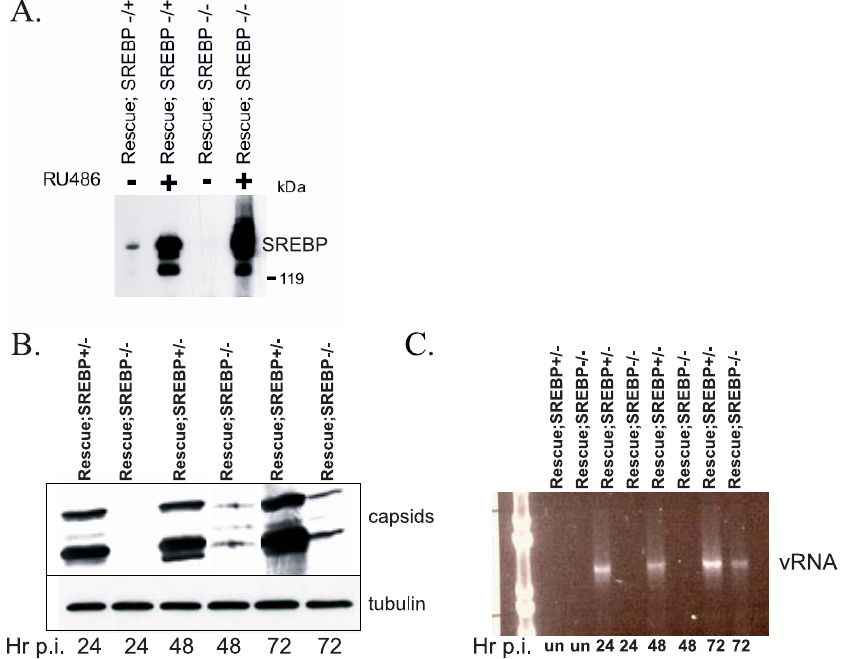
Figure 5. Attenuation of Fatty Acid Biosynthesis in Animals Is Protective (A) SREBP -null flies were generated by rescuing the larval lethality using an inducible transgene and have no detectable SREBP protein as adults as measured by immunoblot probed with anti- SREBP . (B) These SREBP -null flies are resistant to viral infection as measured by viral antigen production post infection. Heterozygous or homozygous SREBP mutant flies were challenged with DCV, and viral antigen production was measured as a function of time postinfection. Protein lysates were generated (hours postinfection indicated [Hr p.i.], normalized, and probed with anti-DCV or anti-tubulin for normalization. (C) SREBP -null flies are resistant to viral infection as measured by viral RNA production postinfection. Heterozygous or homozygous SREBP mutant flies were challenged with DCV, and viral RNA production was measured by RT-PCR at the indicated time points postinfection (Hr p.i.). DOI: 10.1371/journal.ppat.0020102.g005